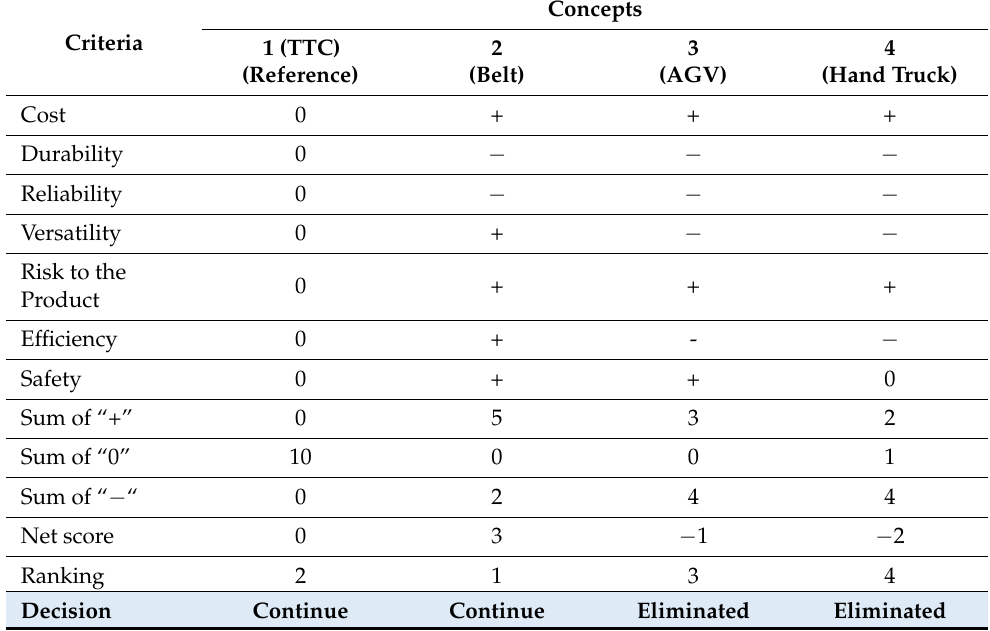
Table 9. Summary of the concept screening results from Concepts 1 to